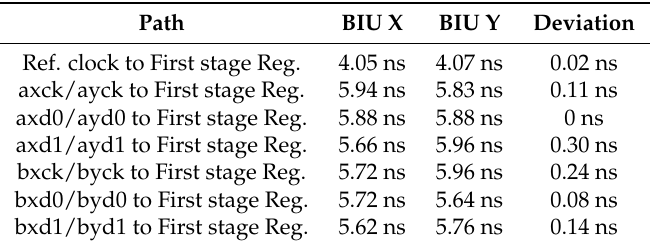
Table 1. Simulation results of the input bus signals. Path BIU X BIU Y